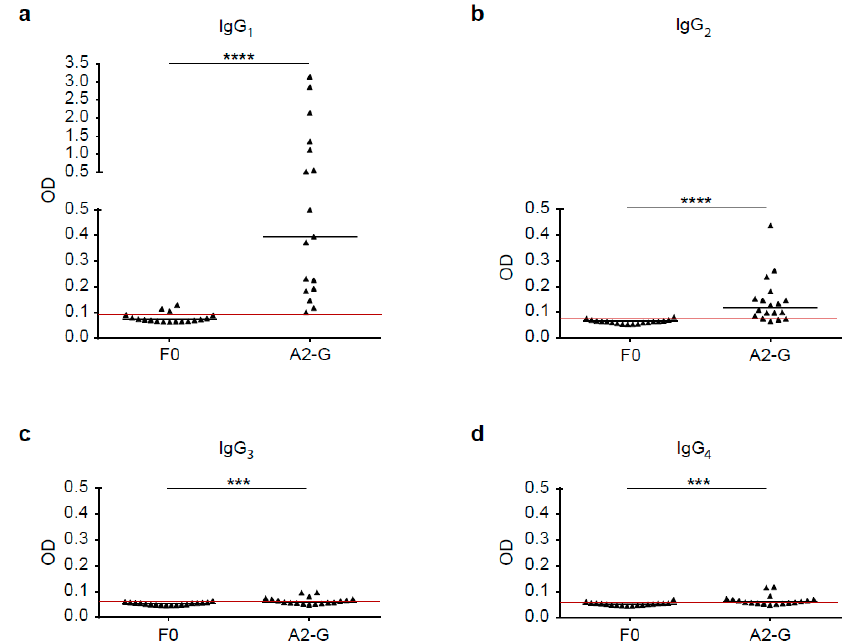
horizontal red lines. Significant di ff erences between G and F0-specific antibody levels are indicated (**** p < 0.0001).